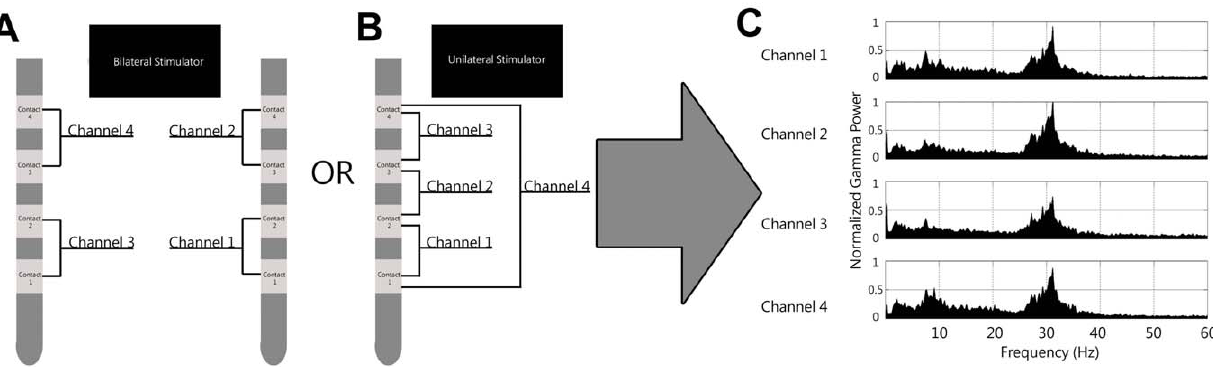
Figure 2. Electrode configuration and representative spectra. A) Subjects were either implanted with one stimulator controlling bilateral leads or B) two simulators each controlling one ipsilateral lead. LFPs were recorded across contact pairs as indicated. For stimulators serving bilateral leads, channels 1 & 2 represent distal and proximal LFPs in one hemisphere. Channels 3 & 4 represent distal and proximal LFPs from the opposite hemisphere. For stimulators serving unilateral leads, channels 1–3 represent consecutive contact pairs. Channel 4 represents a wider field LFP between contacts 1 & 4. C) Representative spectra from four channels recorded from a unilateral stimulator are shown.